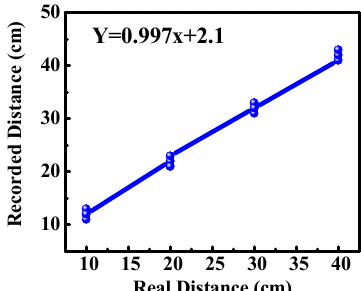
Sensors 2019 , 19 , 130 Figure 6. Comparison of distance between real value and recorded value. Figure 6. Comparison of distance between real value and recorded value.